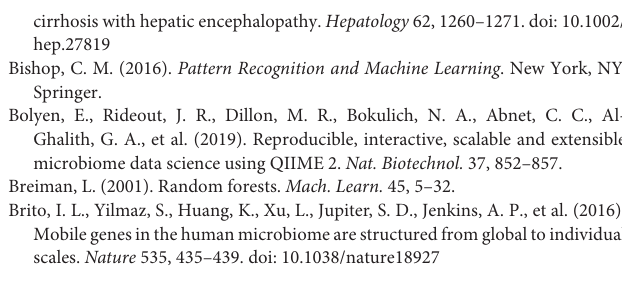
Supplementary Table 1 | List of paired fecal and oral samples from the HMP study as well as from other literature studies dealing with healthy adults (Zaura et al., 2015; Brito et al., 2016; Russo et al., 2018). Both 16S rRNA gene sequencing and shotgun metagenomics studies were considered. For each sample, the following data are reported: sample ID, subject ID (and visit when available), geographical origin, reference, sequencing method and body